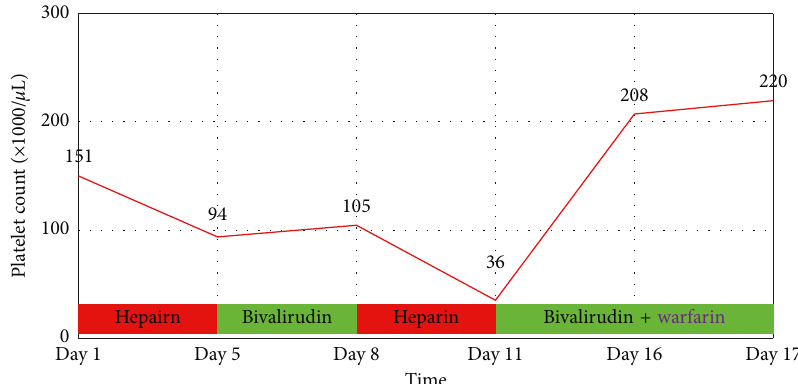
Figure 2: Patient’s platelet trend during hospitalization while on unfractionated heparin and bivalirudin